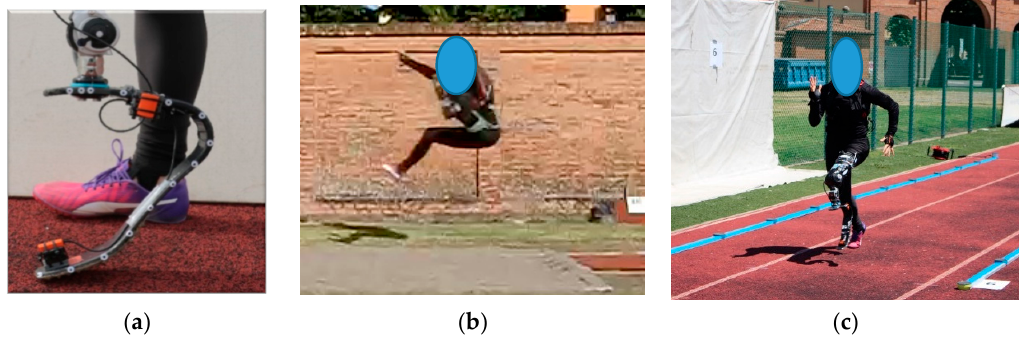
Figure 9. Second field test session setup: ( a ) inertial suit from Xsens applied to athlete KD2, with detail of the RPF arrangement of inertial motion unit (IMU) sensors; ( b ) jumping validation tests with simultaneous collection of GRF from a force platform at the takeoff board and from the iRPF; and ( c ) sprint tests on free track without force platforms.